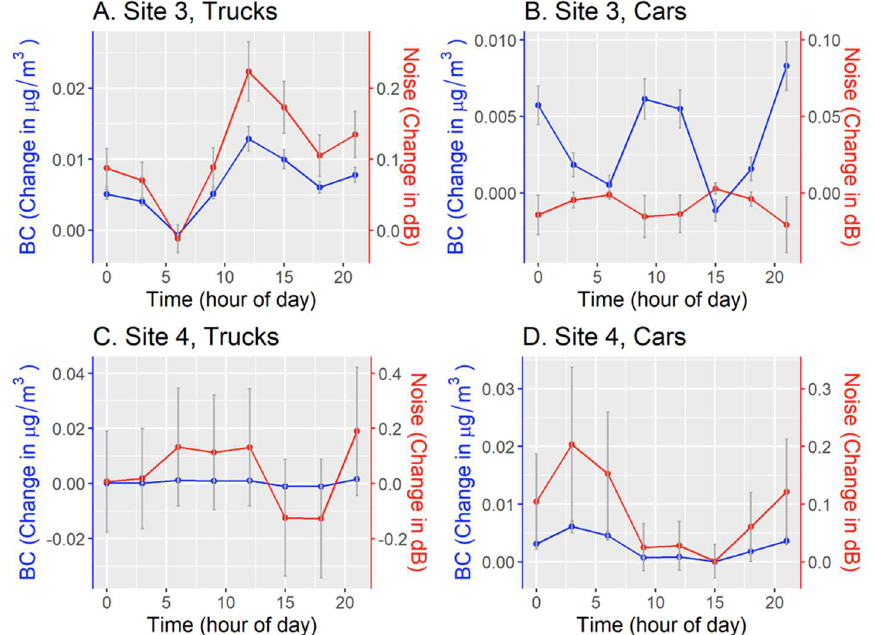
Figure 5. Estimated change in black carbon (blue lines) and noise (red lines) from the average count of trucks and cars attributed to the opening of an online grocery delivery service warehouse at two study sites. Points where the line segment changes direction corresponding to the value at the start hour of a 3-h time window (i.e., the value at time = 0 corresponds to the value at Midnight for the Midnight to 3 AM time window). Gray error bars represent the mean +/- the standard error.